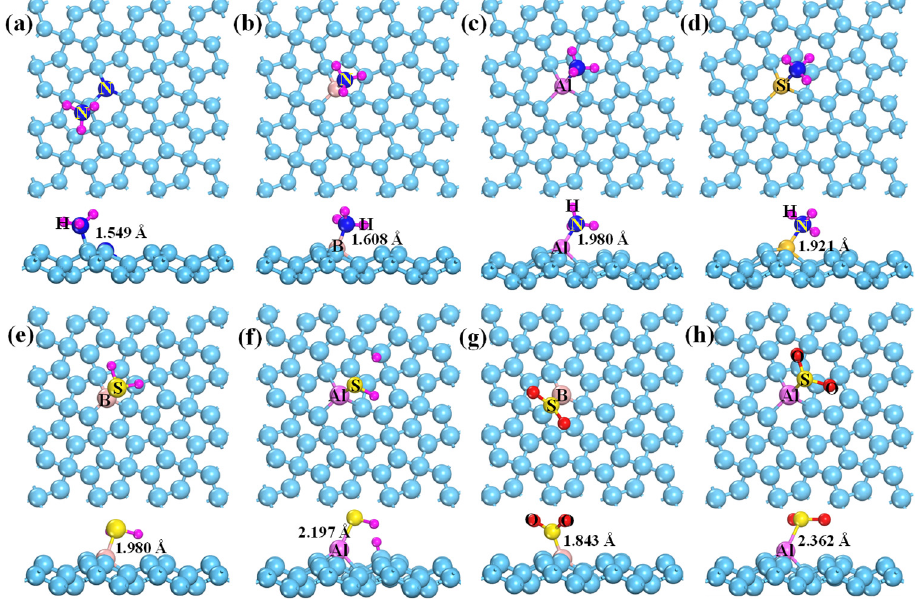
Figure 5. Fully-relaxed structures of different adsorption systems. NH 3 adsorbed on N-PG ( a ), B-PG ( b ), Al-PG ( c ), and Si-PG ( d ); H 2 S adsorbed on B-PG ( e ) and Al-PG ( f ); SO 2 adsorbed on B-PG ( g ) and Al-PG ( h ).